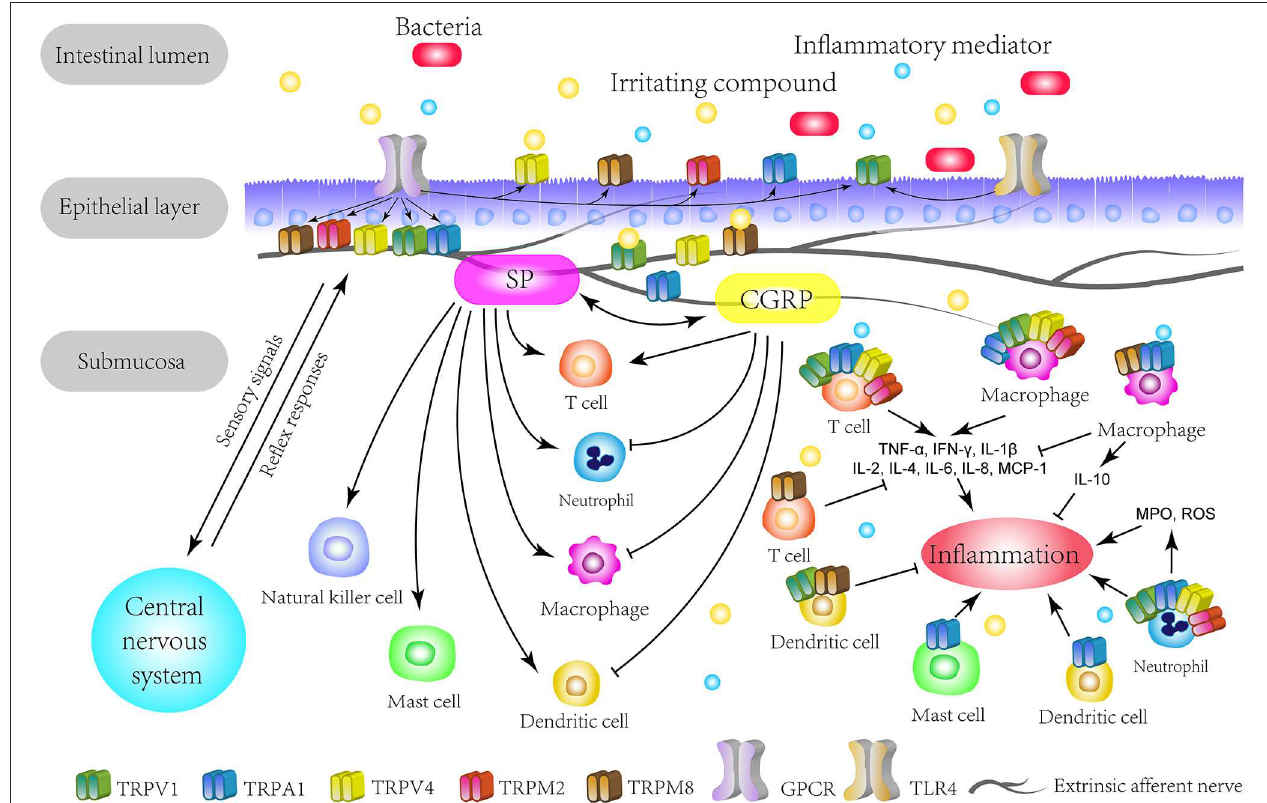
FIGURE 1 | The overview of TRP channels involved in IBD. The TRP channels mainly express themselves on extrinsic primary afferents in the intestine. TRP channels directly detect various stimuli in the intestinal lumen and act as secondary transducers for GPCR. Specially, TRPV1 and TRPA1 can crosstalk with microbiota through TLR4 or in a TLR4-independent manner. Upon activation, TRP channels transduce the sensory signal to the central nervous system and lead to autonomic reflex responses. This mechanism could be enhanced by inflammatory mediators and be responsible for the visceral hypersensitivity on pathological conditions. Meanwhile, the activation of TRP channels triggers neurogenic inflammation with neuropeptides, such as CGRP and SP, which can interact with immune cells. On the other hand, TRP channels express on multiple immune cells and regulate their functions, thus promoting or restraining the initiation or process of inflammation. Therefore, based on the immunomodulatory effects, TRP channels play a role in the immune pathogenesis of IBD. GPCR, G-protein coupled receptors; TLR4, Toll-like receptor 4; SP, substance P; CGRP, calcitonin-gene-related peptide; TNF- α , tumor necrosis factor alpha; IFN- γ , interferon gamma; MCP-1, macrophage chemoattractant protein-1; MPO, myeloperoxidase; ROS, reactive oxygen